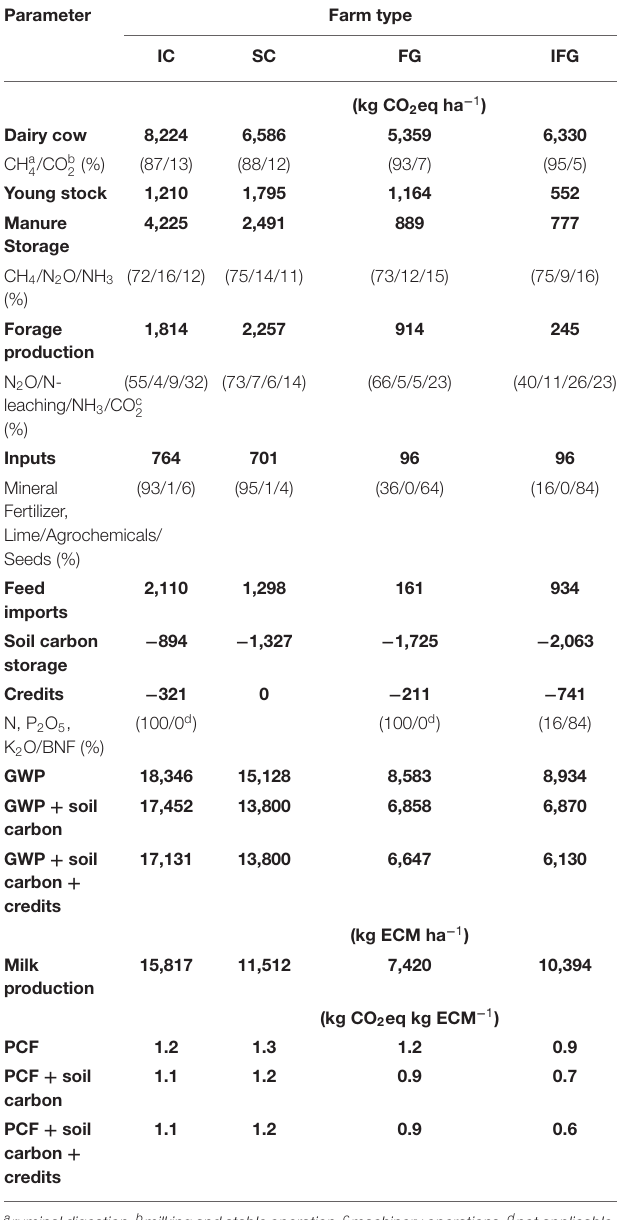
TABLE 4 | N-balance of the prevailing farm types (IC, intensive-confinement; SC, semi-confinement; FG, full-grazing; IFG, integrated full-grazing). Parameter Farm